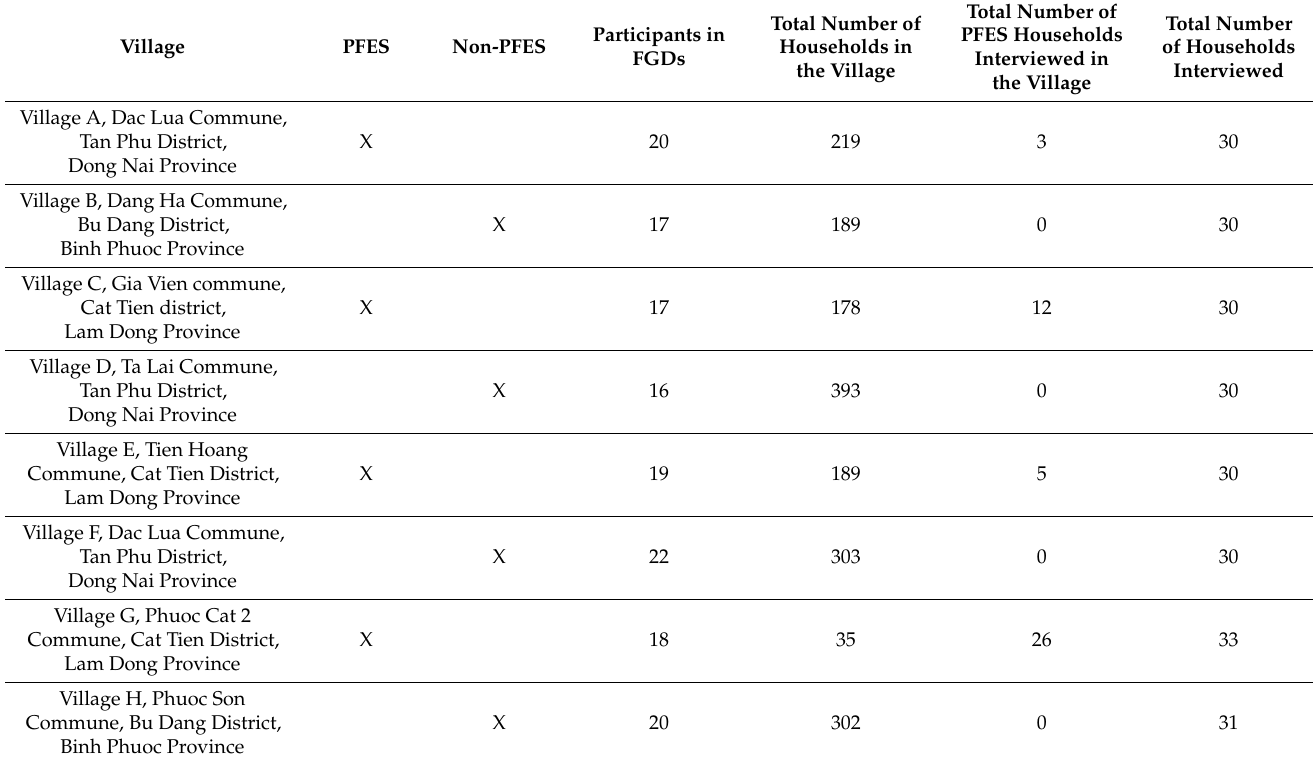
Table 3. Basic information on villages participating in the study, including participants in focus group discussions and in-depth